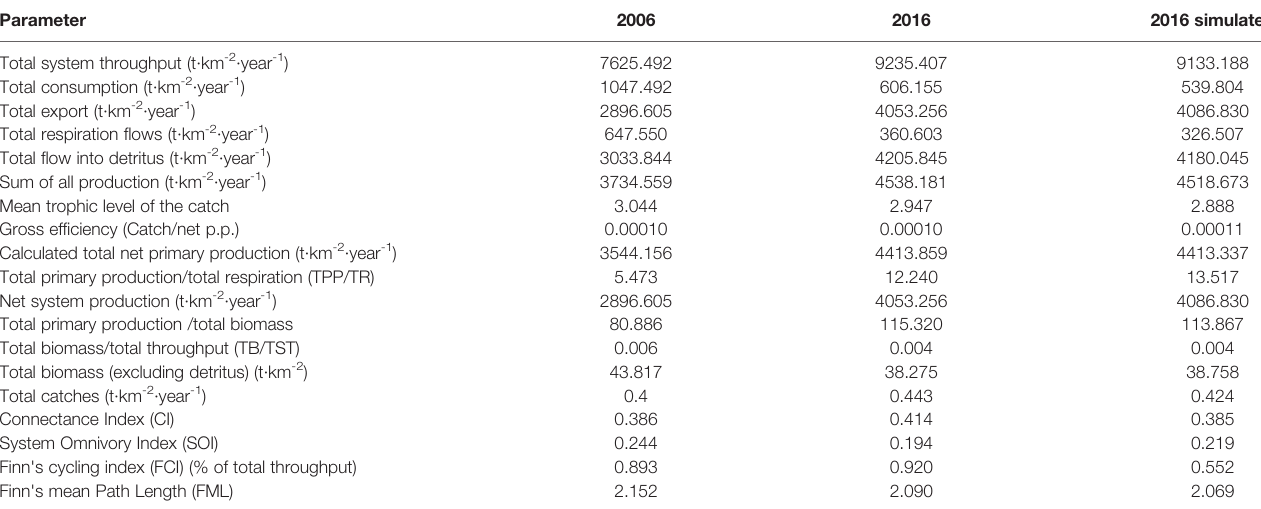
TABLE 3 | Summary of the indices for Minjiang Estuary